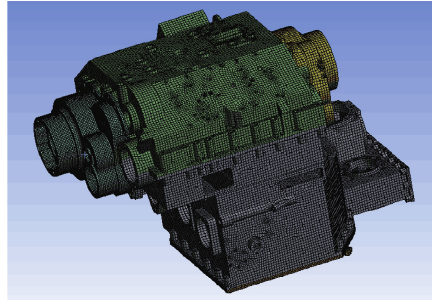
Figure 6: Housing finite element model.